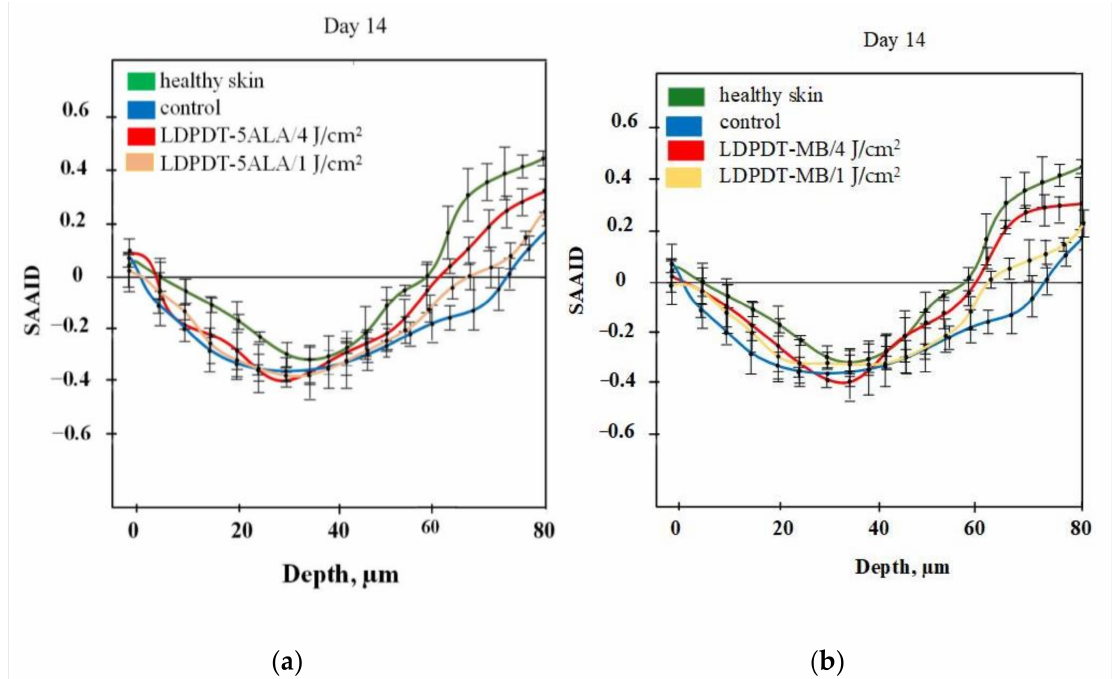
Figure 8. ( a ) SAAID for LDPDT–5-ALA (4 J/cm 2 and 1 J/cm 2 ) groups; ( b ) SAAID for LDPDT–MB (4 J/cm 2 and 1 J/cm 2 )